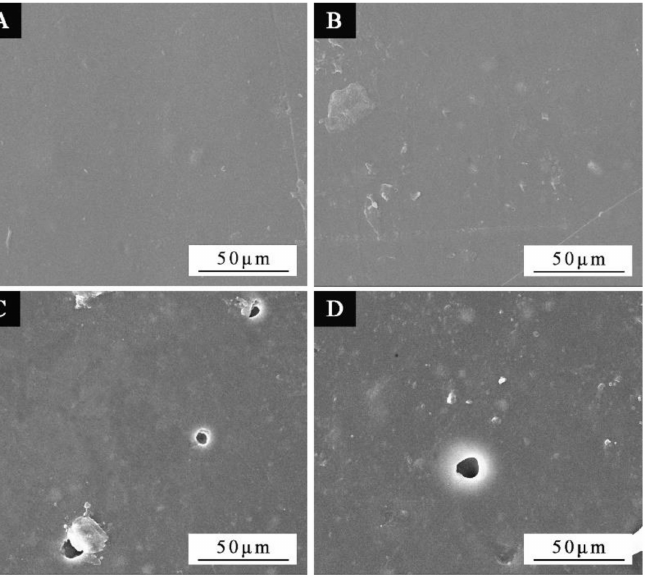
Figure 7. SEM images of coating films with and without microcapsules before and after 160 ◦ C aging: without microcapsules ( A ) before aging, ( C ) after aging; with microcapsules ( B ) before aging, ( D ) after